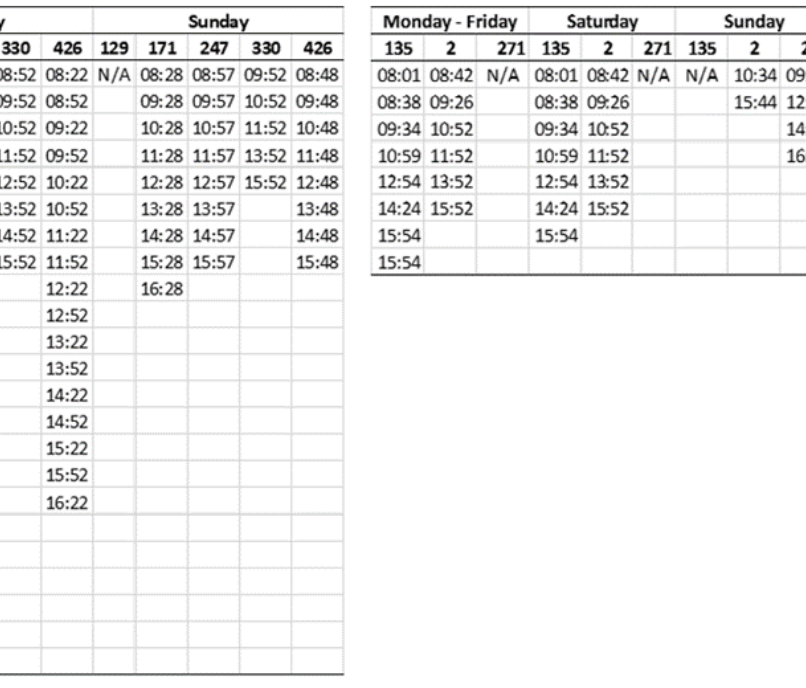
Figure 3. Public transport network consisting of bus routes and light and heavy rail. Insert maps ( a – c ) illustrate further details within three major cities.